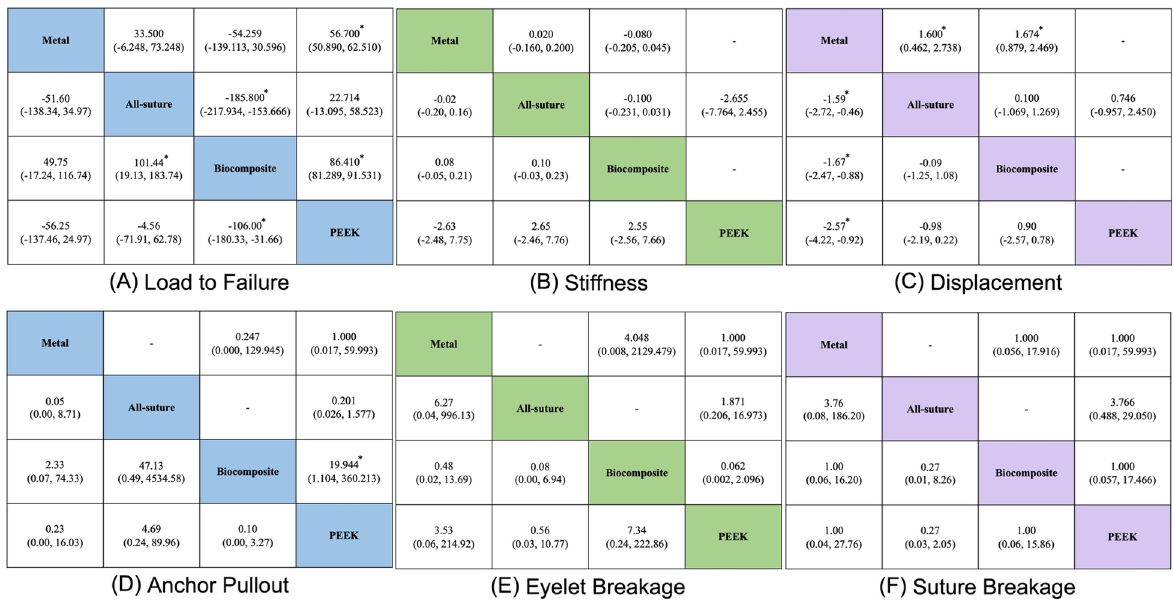
Fig. 5 League Table and Pairwise of Each Biomechanical Property. The results of the network meta‑analysis are presented in the lower‑left half, whereas those of the pairwise meta‑analysis are presented in the upper‑right half. In ( A ‑ C ), the weighted mean differences with 95% confidence intervals (CIs) are presented. If the 95% CIs crossed 0, the differences are not statistically significant. In ( D ‑ F ), odds ratios (ORs) with 95% CIs are presented, and the column‑defining treatment is favored if the odds ratio is < 1. If the 95% CIs crossed 1, there are no significant difference between groups. The stars marked in the figure refer to significant